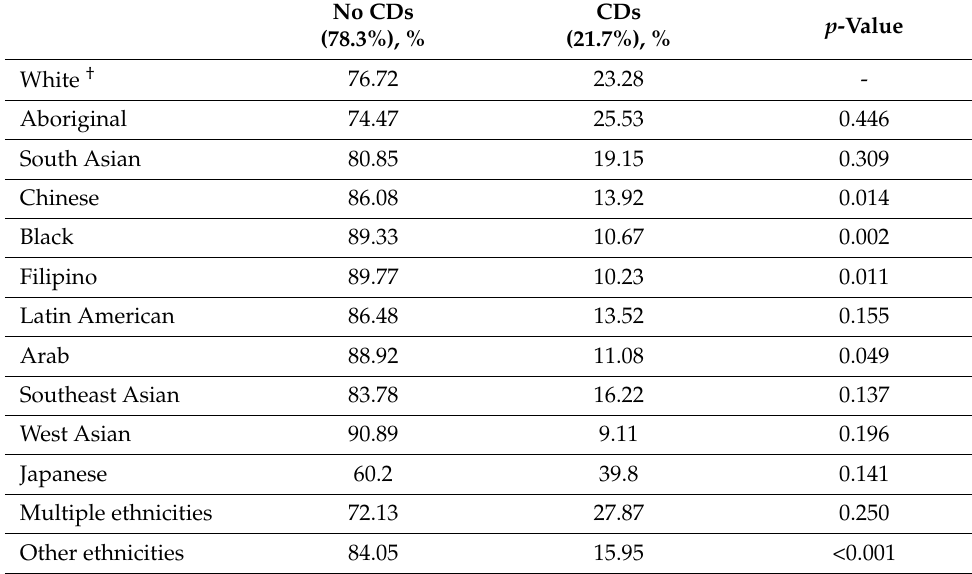
Table A2. Weighted prevalence of chronic diseases by ethnicity.